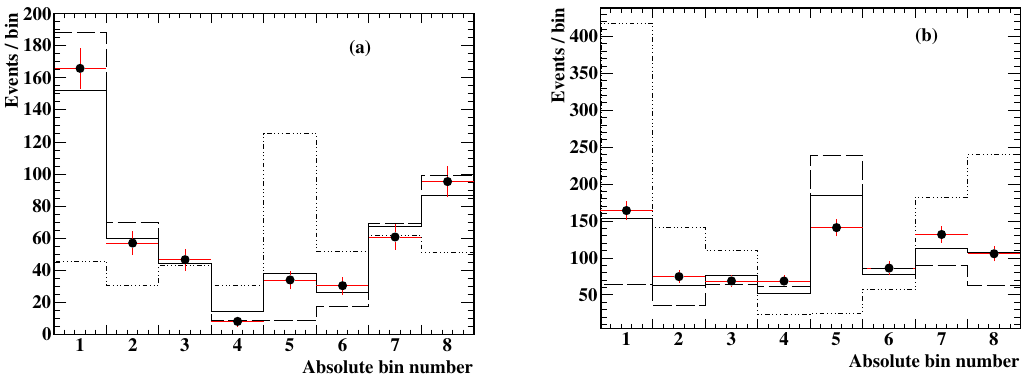
Table 4 . F + results for the mode K 0 K 0 (cid:25) + (cid:25) (cid:0) indicates that the combined (cid:12)t includes both the samples. The (cid:12)t quality metric (cid:31) 2 =DoF S ; L is also shown, where DoF stands for the number of degrees of freedom.